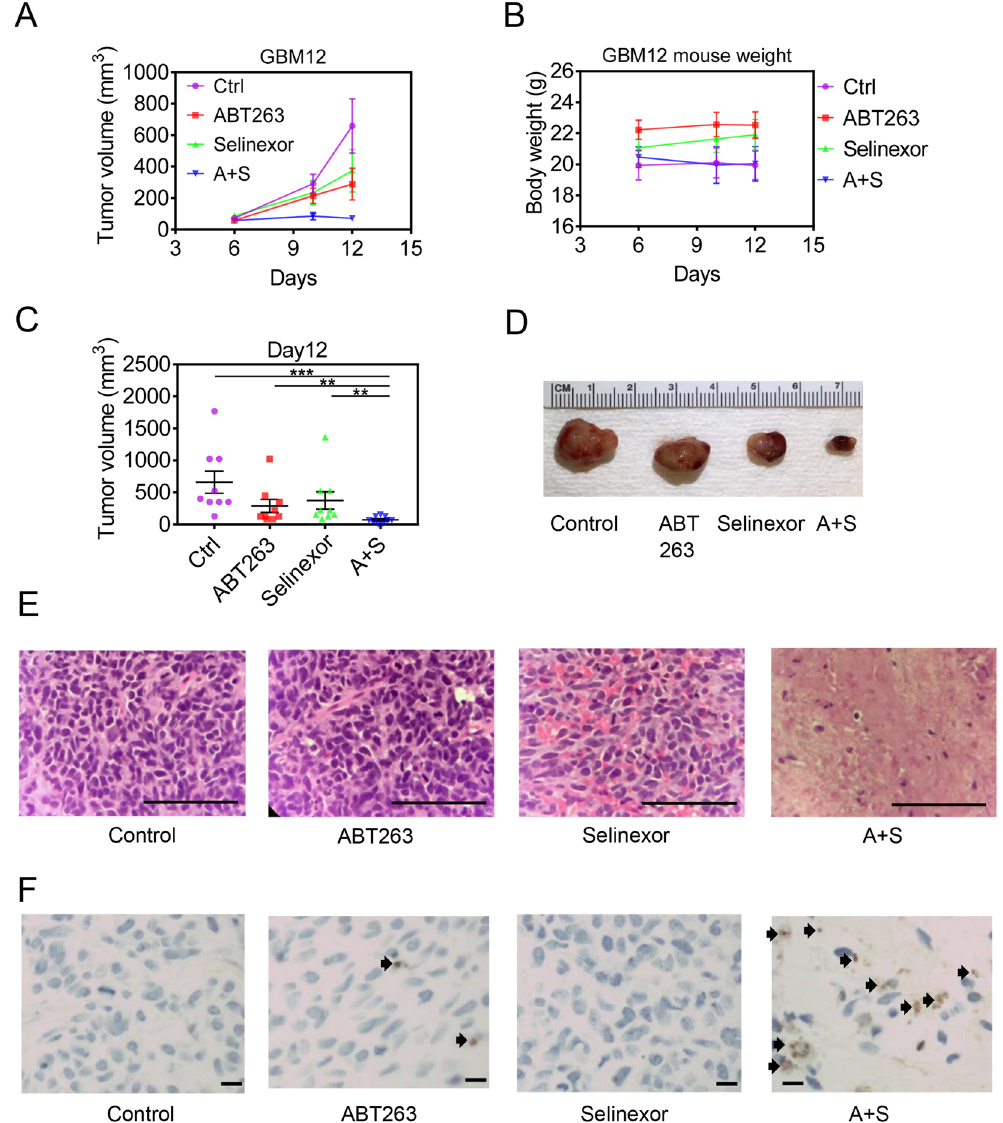
Figure 6. The combination treatment of ABT263 and selinexor reduces tumor growth stronger than vehicle or single treatments in a patient-derived xenograft model of human GBM. ( A ) Patient-derived xenograft model (GBM12) was implanted subcutaneously in nude mice. Once tumors became palpable and were about to enter an exponential growth rate, four treatment groups were randomly assigned: A, Vehicle (Ctrl), ABT263, selinexor or ABT263 + selinexor (A + S). Two treatments were given, consisting of vehicle, 75 mg/kg ABT263, 10 mg/kg selinexor or the combination. Tumor growth was measured and is plotted as volume over time (days). Shown are means and SD. ( B ) for the same experiments described in A weight measurements were taken for the individual groups. ( C ) On the day of conclusion of the experiment described in A, statistical analysis was performed. Shown are means and SD. ( D ) Representative gross images of the individual groups are shown after conclusion of the experiment. A + S: ABT263 + selinexor. ( E ) Tumors from the individual groups were fixed, embedded in paraffin and paraffin section were stained with standard hematoxylin and eosin staining (H&E). Shown are representative images from the individual treatment groups. F, Tumors from the indicated groups were stained with TUNEL. Representative images are shown and arrows highlight TUNEL positive cells. * p < 0.05; ** / *** / **** p <